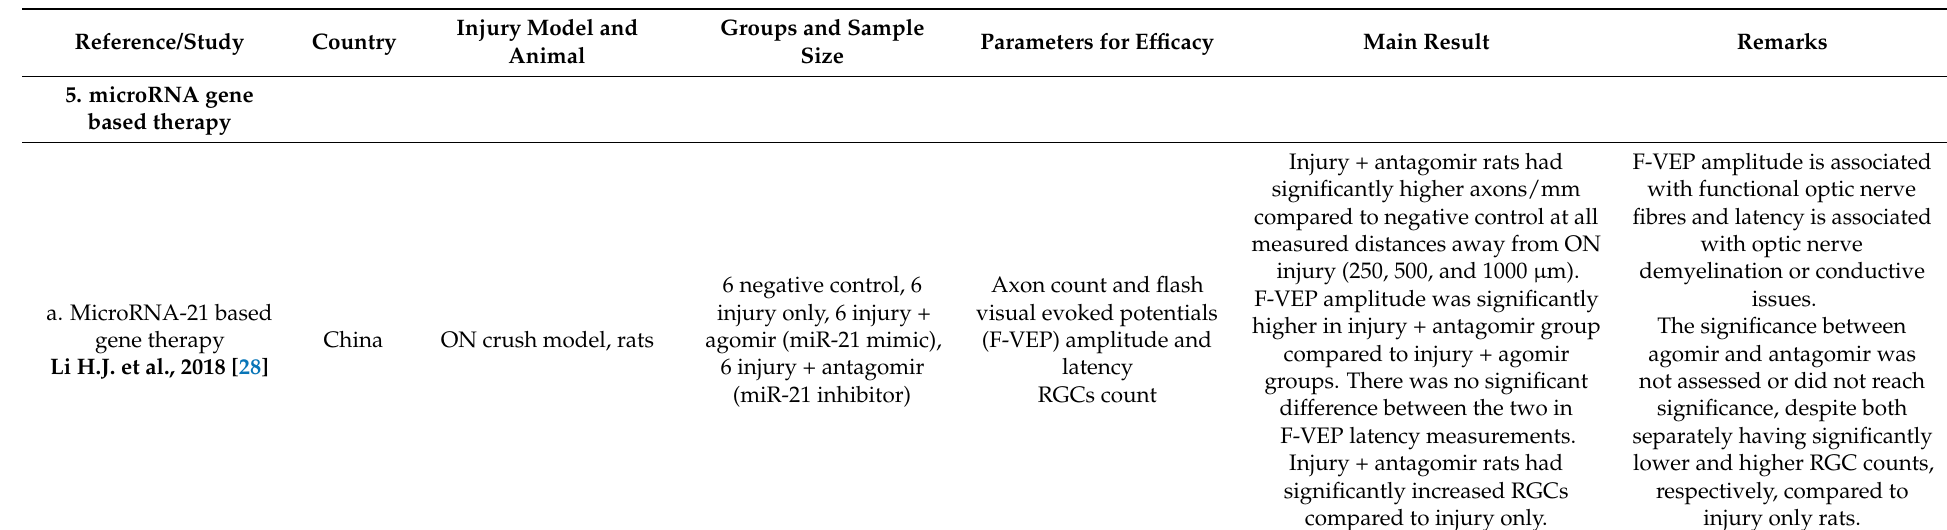
Table 5. Summary of in vivo studies utilizing microRNA as gene